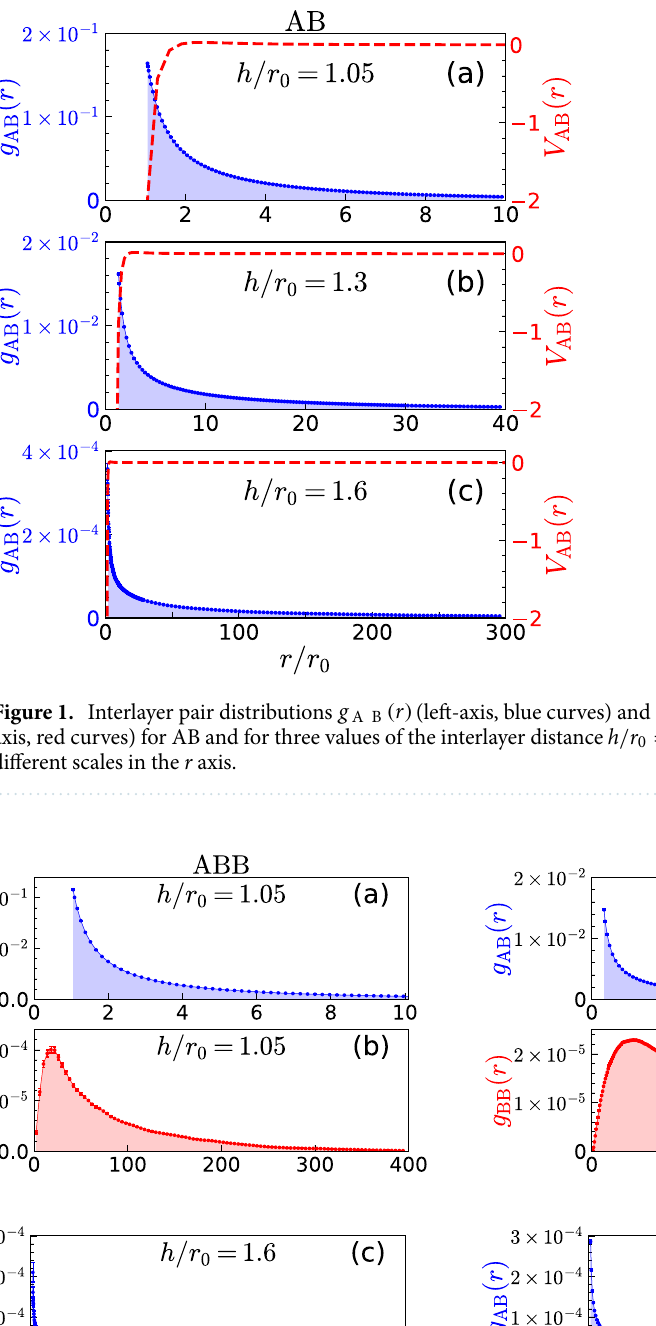
Figure 2. Interlayer and intralayer pair distributions, g A B ( r ) and g B B ( r ) , for ABB ( a , b , c , d ) and AABB ( e , f , g , h ) clusters, and for different values of the interlayer distance h / r 0